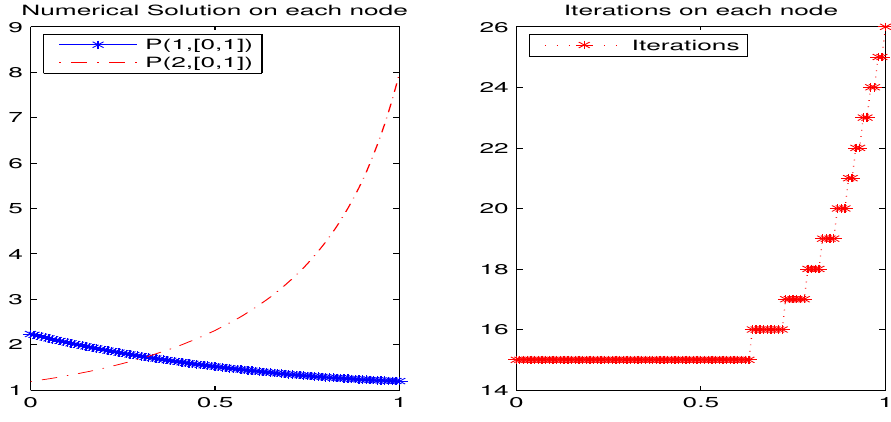
Figure 1. Numerical solution and iterations on each